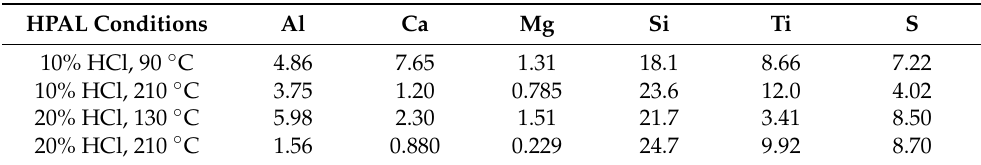
Table 4. Chemical composition of the solid residues obtained by the leaching of the SSAT sample at S:L ratio = 1:11 for 60 min (wt.%).